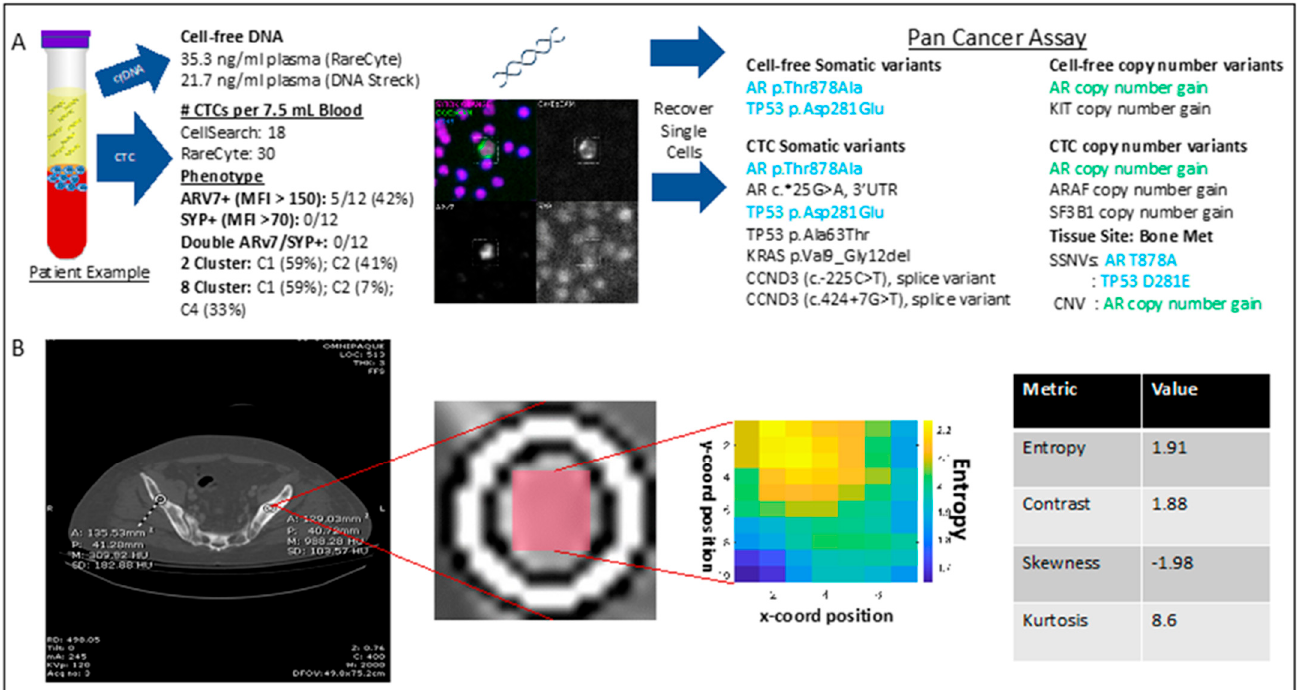
Figure 8. Multiparametric profile of individual patient. A . Liquid biopsy result summary for an individual mPC patient (ID number 822). Results displayed include cell-free DNA quantity, CTC counts and cellular phenotypes (left), and detection of somatic variants in cfDNA, CTC and tissue biopsy (right). Blue indicates somatic variants shared in cfDNA, CTC and tissue biopsy. Green indicates copy number variants shared in cfDNA, CTC and tissue biopsy. B . Radiomic analysis performed on a metastatic bone lesion (round ROI). Lesions were identified and segmented by an expert radiologist using ITK software. In all cases, the normal bone (square ROI) was also segmented. From within the segmented contours, the largest ROIs (shaded in red) were extracted for radiomics analysis. Texture analysis was performed with CaPTk software. To avoid overfitting in this pilot study, radiomic analysis was focused on intensity characterization and grey-level co-occurrence matrix (GLCM) analysis.